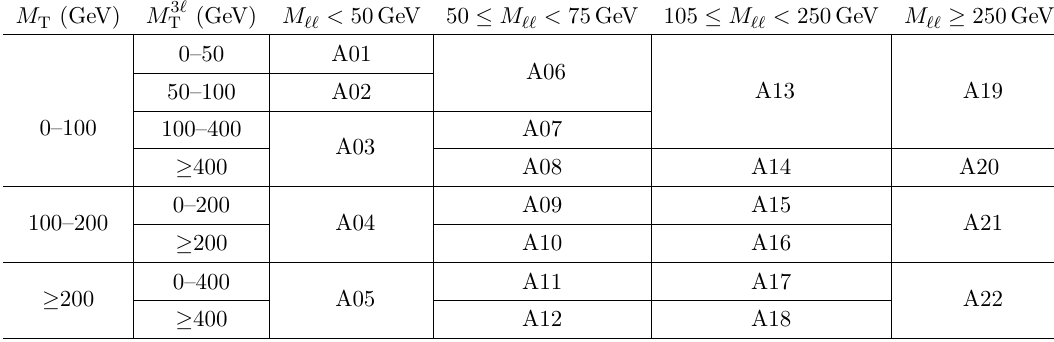
Table 3 . Definition of the search regions used for events with three light leptons, at least two of which form an OSSF pair, excluding those with 75 < M